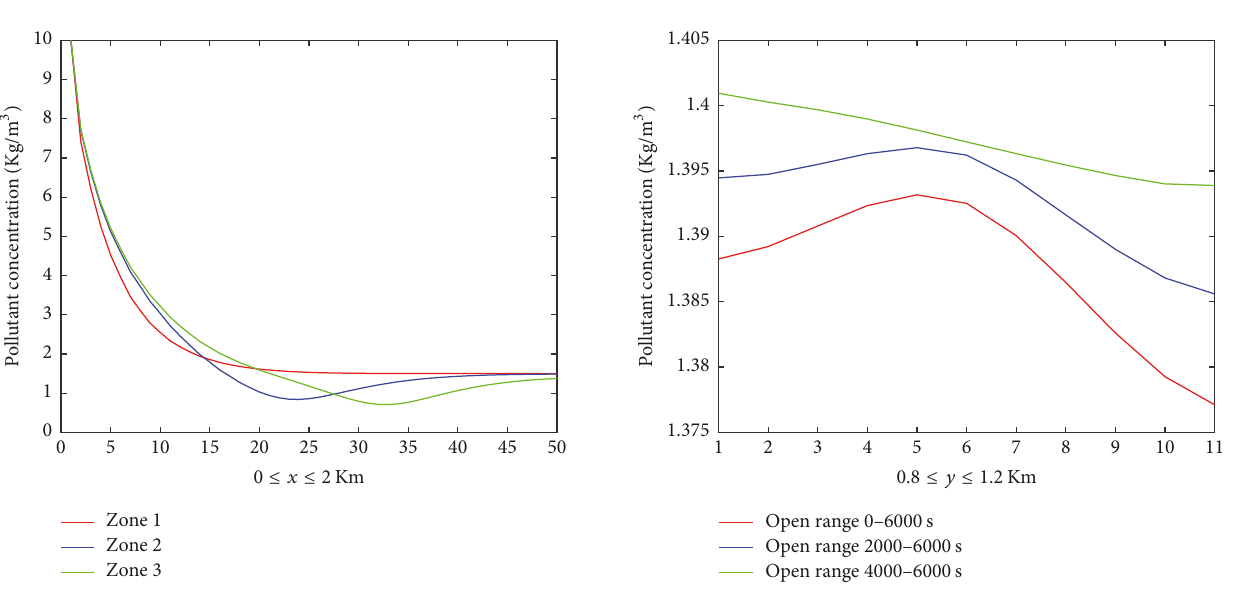
Figure14:Theapproximatedpollutantconcentrationsovertheeast- ern exit gate is opened on 0–100 min, 33–100 min, and 66–100min, when 𝐶(𝑥,𝑦,𝑡) for all 800 ≤ 𝑦 ≤ 1200 m and 𝑥 = 2000 m.